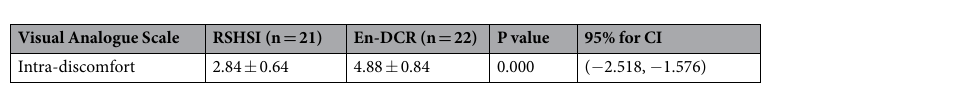
Figure 7. Outcomes of epiphora improvement respectively after the RSHSI or En-DCR described as frequency. n = the number of operative eyes. ( χ 2 = 1.804, P = 0.406).